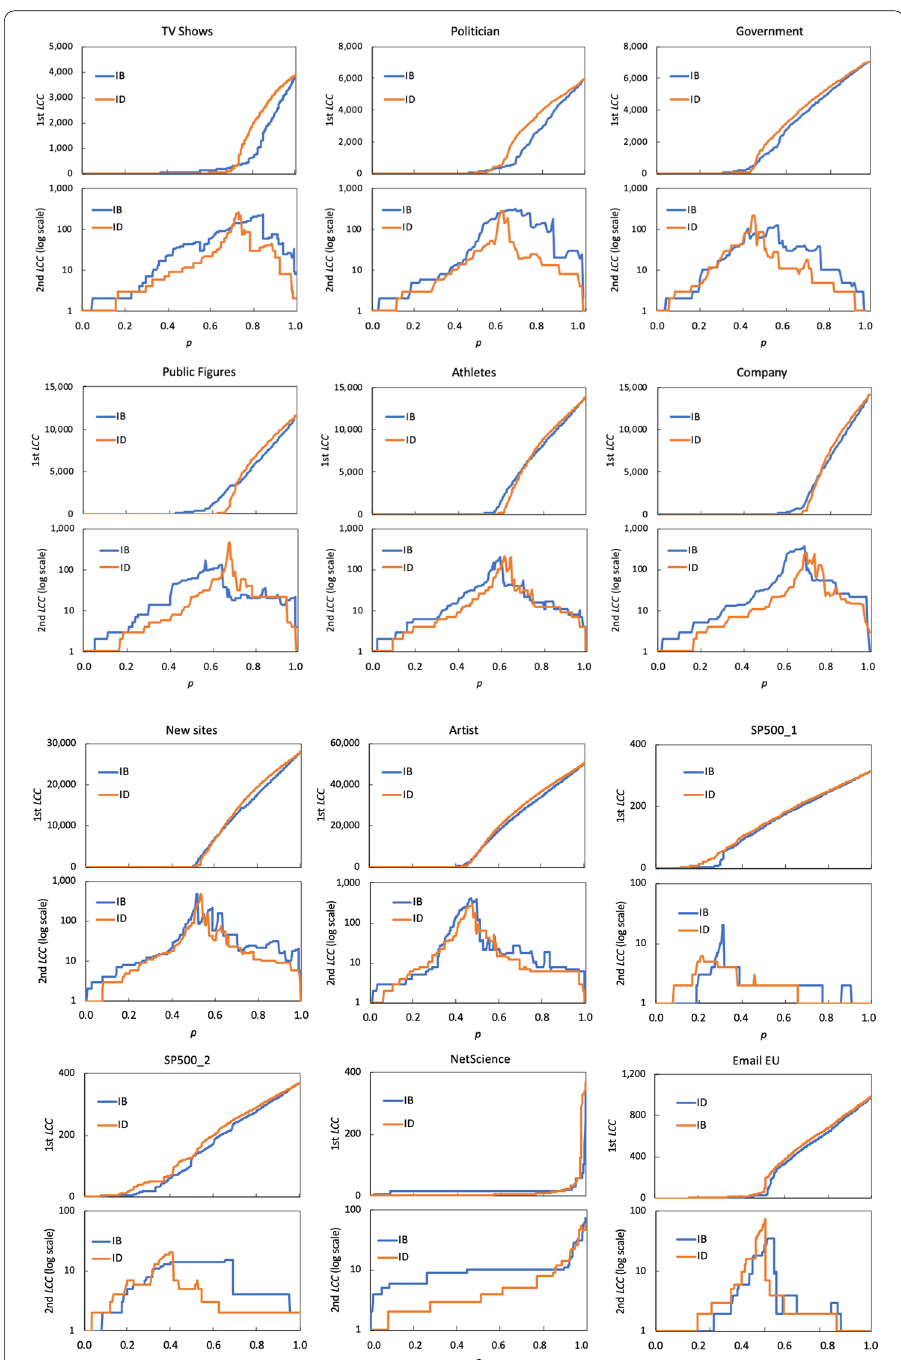
when attacked by IB and ID